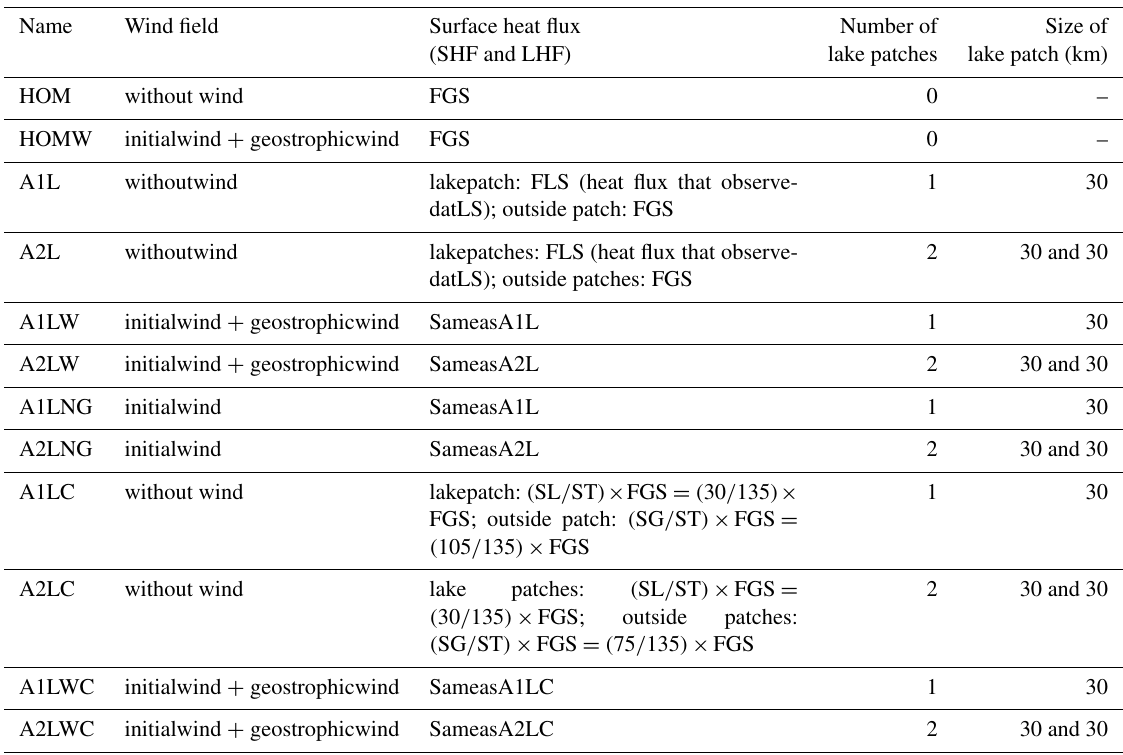
Table 1. Parameters for the 3D simulations over the homogeneous surface (HOM) and heterogeneous surface with surface heat flux anomalies (A) under different conditions: with one (1L) or two (2L) lake patches, with initial wind and geostrophic wind (W), without geostrophic wind (NG), and with the constant surface heat flux